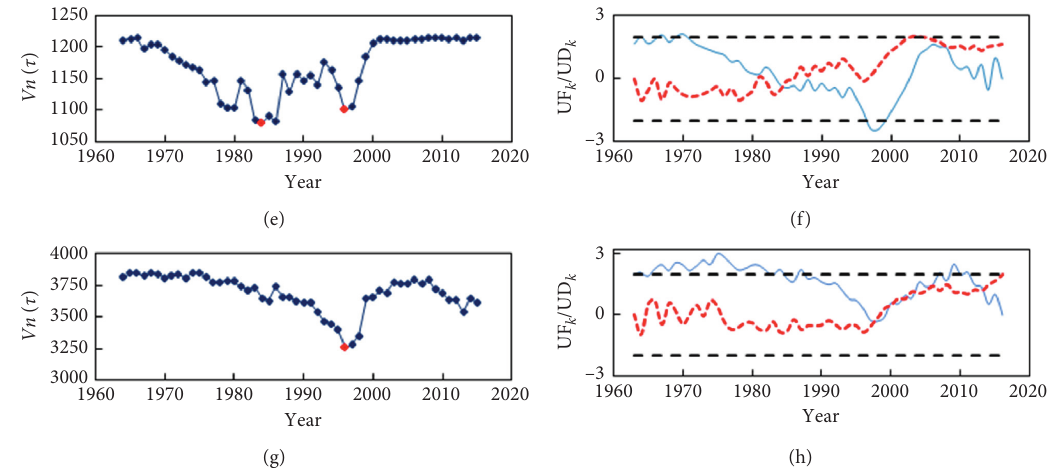
Figure 6: Abrupt change diagnosed graphs of the ordered clustering method ((a), (c), (e), and (g)) and Mann–Kendall mutation test ((b), (d), (f), and (h)) for max one-day precipitation amount in the four subregions.